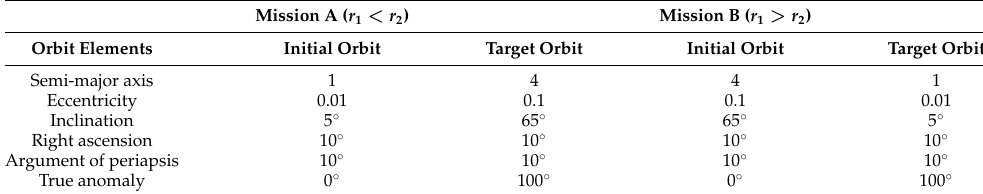
Table 1. Orbit elements of two